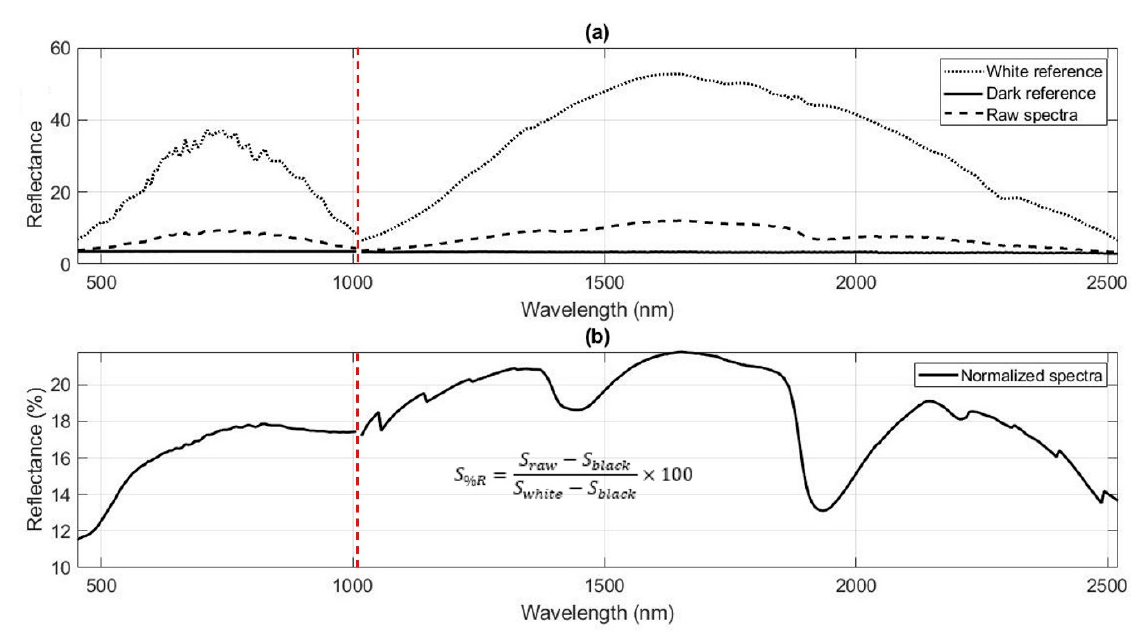
Figure 6. ( a ) Characteristic spectra of the white (99% reflectance) and black references used by our HSI core logger with VNIR and SWIR sensors (the red dotted line delimits the separation between the two cameras), as well as raw and ( b ) normalized spectra.